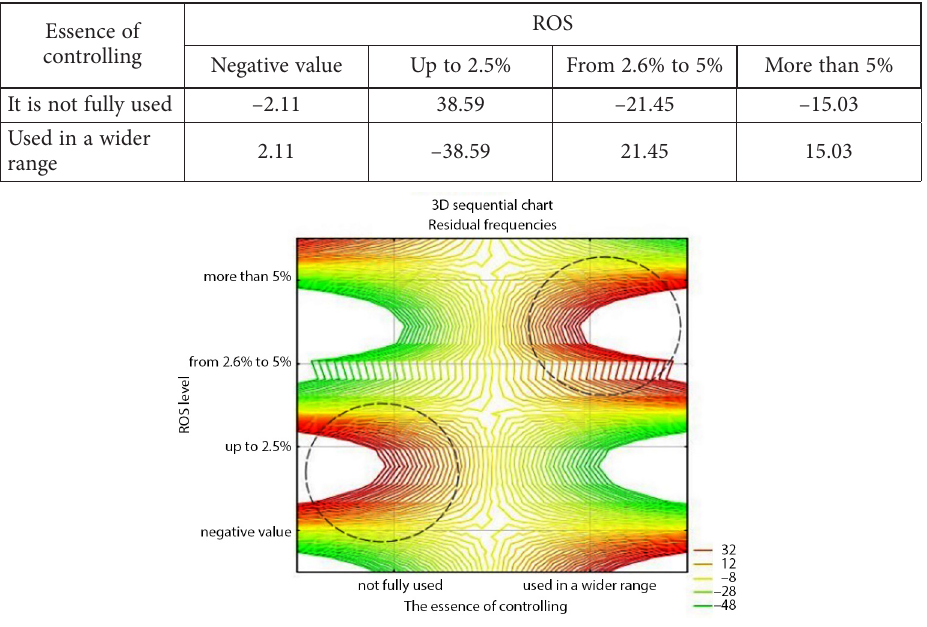
Figure 2. The essence of controlling and the level of